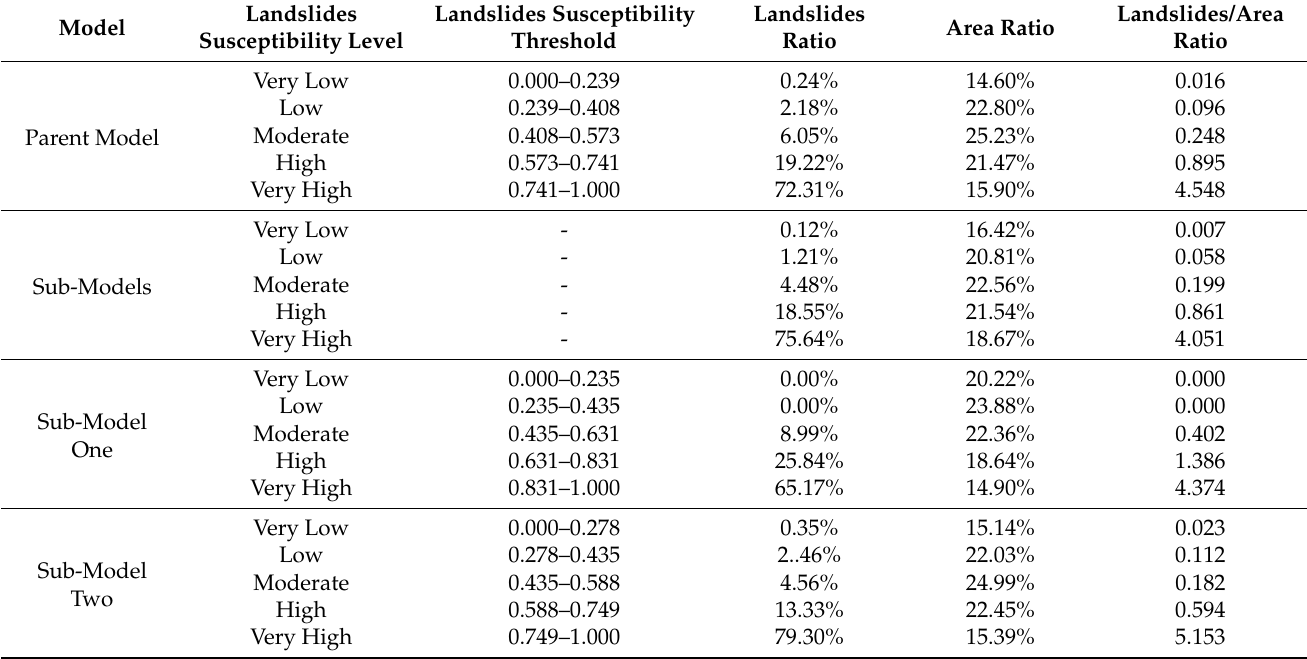
Figure 8. Comparison between the landslide susceptibility mapping of the parent model and sub- models: (a) Landslide susceptibility map generated by the parent model, (b) Landslide susceptibility map generated by the sub-models, (c) Detailed view of landslide susceptibility map generated by the sub-models, (d) Detailed view of landslide susceptibility map generated by the parent model. Table 5. Statistic results of landslide susceptibility in different levels of different models.